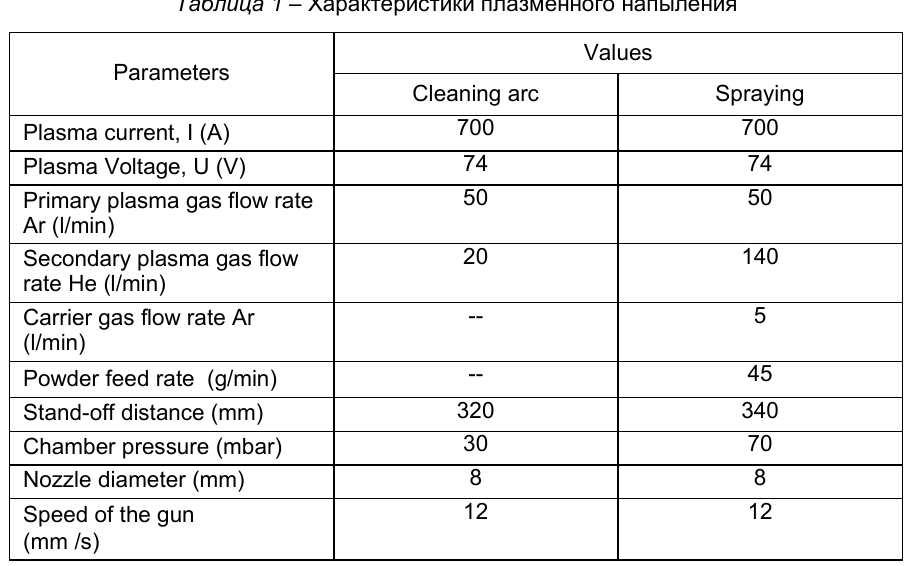
Table 1 – Plasma spray parameters Tabela 1 – Plazma sprej parametri Таблица 1 – Характеристики плазменного